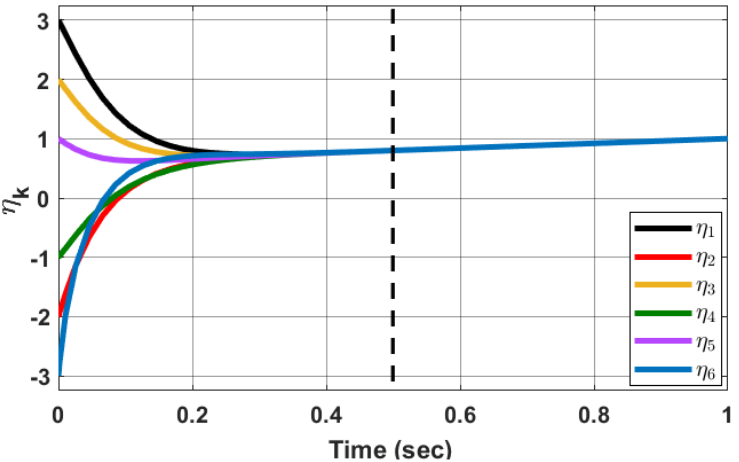
Figure 4. Synchronization of system (2) states with the adaptive state-feedback control (44) ( ζ ( t ) = 0) in time τ f = 0.5